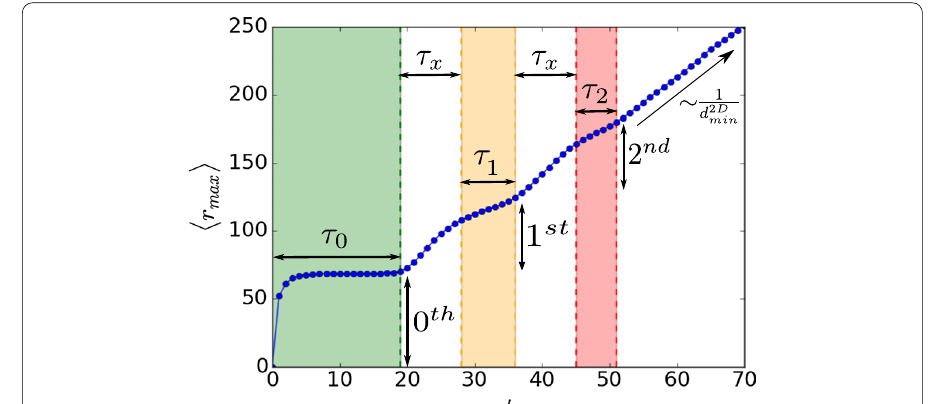
Fig. 4 Epidemic spatial propagation. The average maximum extent of the epidemic, (cid:31) r max (cid:30) , is measured as a function of time at β 2 D c . At early times the epidemic spread locally within the origin city (zeroth circle) for a period of time τ 0 with a constant � r max � ∼ ζ . Afterwards, the epidemic spread to the first circle of cities around the origin city for a period of time τ 1 and later to the second circle of cities for a period of time τ 2 . The transition time between the circles is denoted by τ x . As the epidemic evolves the distinction between circles decreases and identifying the distance of the disease from the origin is less clear. At later times the distinction of circles disappear completely and a clear spatial propagation is observed with � r max � ∼ t 1 / d 2 D min = t 1 / 1.13 (Bunde and Havlin 1991). The reason for the disappearance of the distinction between circles at later times is because the epidemic may spread faster in a given area and slower in another leading to inconclusive distinction between circles. Here we used ζ = 100 , K = 4 , k inter = 10 − 3 , L = 1000 and β 2 D c =